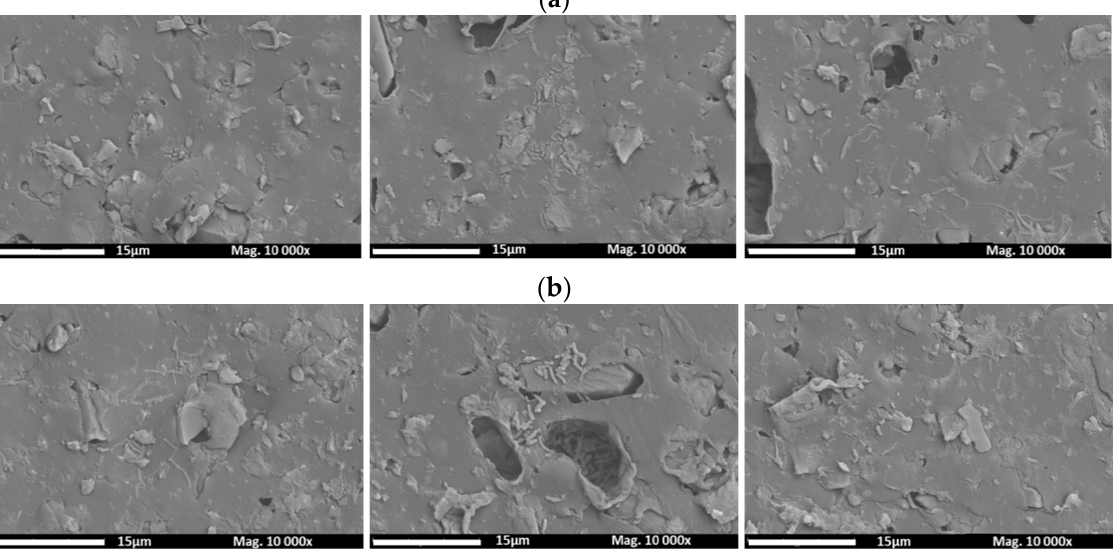
Figure 6. Images of the top surface of the membranes (taken in three different zones) obtained by SEM: ( a ) unmodified membrane and ( b ) modified fouled membrane after chemical cleaning.